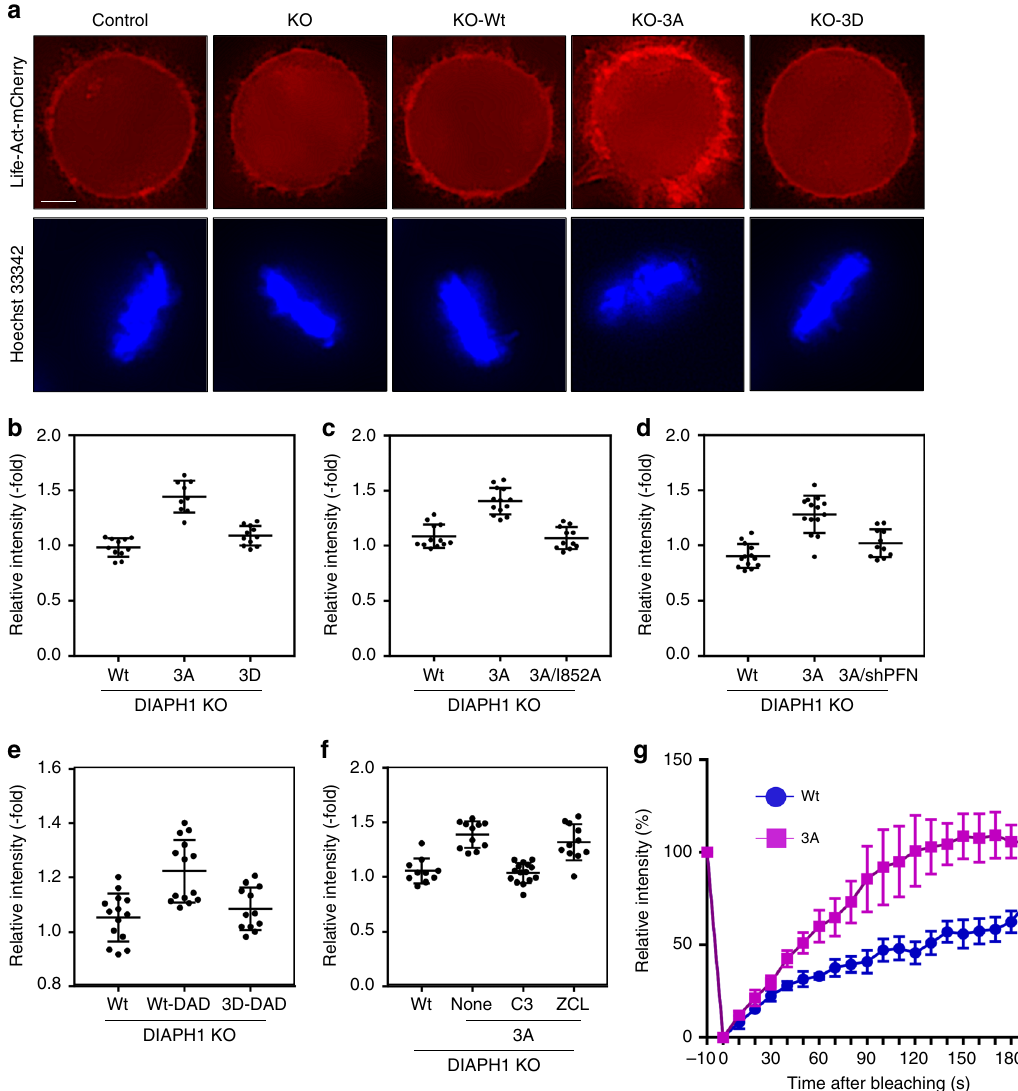
Fig. 3 Expression of DIAPH1-3A accumulates F-actin on the cellular cortex. a Actin fi laments are enriched on the cellular cortex of LifeAct-mCherry-KO-3A cells. Control or LifeAct-mCherry-KO-Wt, − 3A, or − 3D cells were stained with Hoechst 33342 for 10 min to monitor mitotic progression. Representative images shown are equally processed with BZ-II analysis software. Scar bar: 10 μ m. b Cells as in a were imaged by microscopy without fi xation. Relative signal intensities of mCherry at the cell cortex, cytoplasm, and background (the region without cells) were quanti fi ed using Image J software, the background was subtracted from each value, and their ratio (cortex,cytoplasm) was calculated. Wt: n = 11, 3A: n = 9, 3D: n = 11. Bars indicate means ± SD.